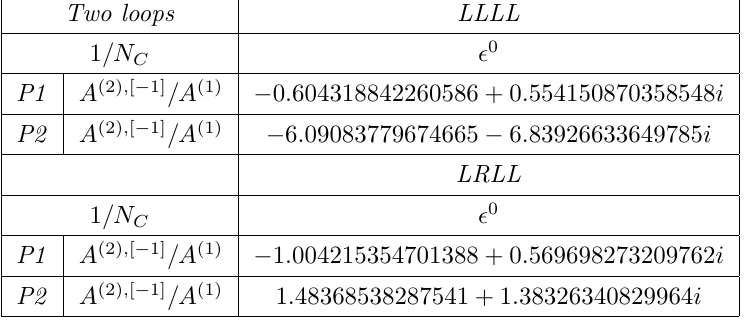
Table 5. Evaluation of the two-loop helicity amplitudes for the phase space points defined in eqs. (5.2) and (5.3) for the sub-leading colour contribution, which is finite after mass renormalisation. We normalise by the one-loop amplitude A (1) | (cid:15) =0 and set the renormalisation scale µ = 2 m W .